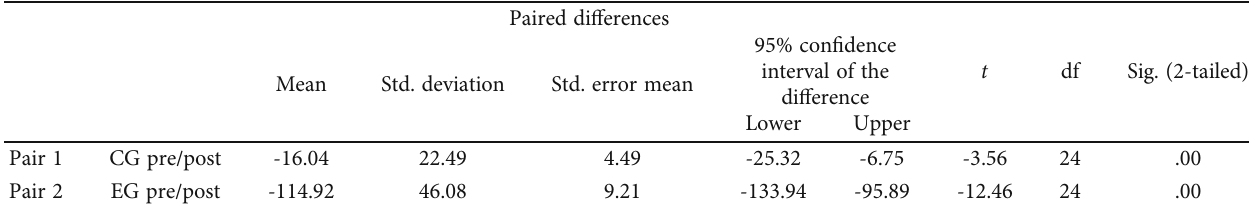
Table 10: Comparing the motivation pre- and posttests of each group (paired samples T -test). Paired di ff erences